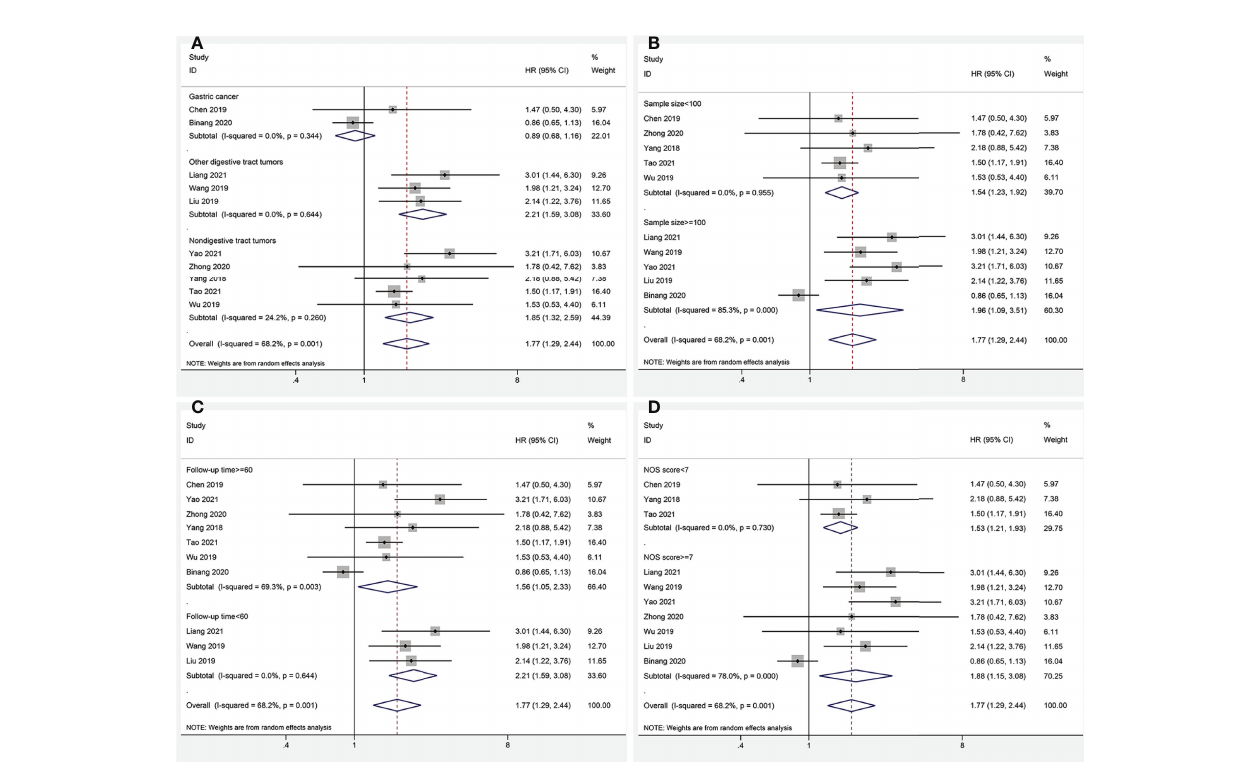
FIGURE 3 | Forest plots for subgroup analysis of FOXP4-AS1 expression with overall survival. (A) Subgroup analysis strati fi ed by cancer type. (B) Subgroup analysis strati fi ed by sample size. (C) Subgroup analysis strati fi ed by follow-up time. (D) Subgroup analysis strati fi ed by NOS